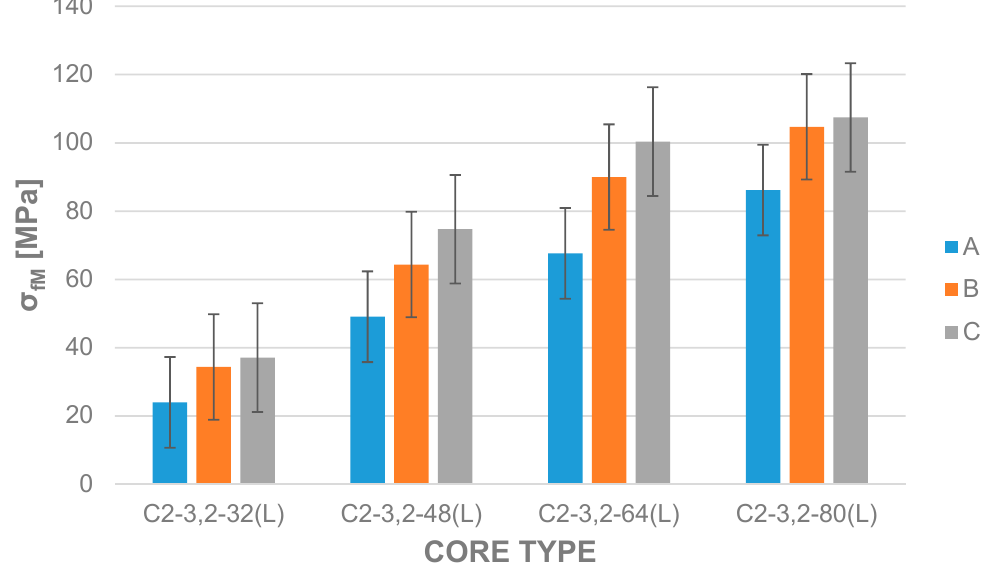
Figure 9. Influence of honeycomb density (32, 48, 64, 80) kg · m − 3 on the bending strength of sandwich constructions A–C (L orientation).